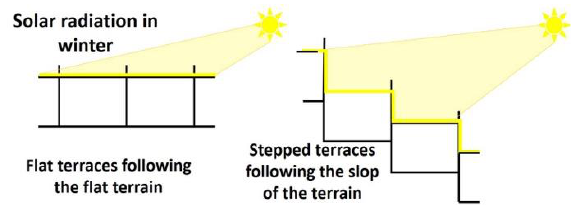
Figure 4. Schema that illustrates how stepped terraces ensure more exposure to winter solar radiation.